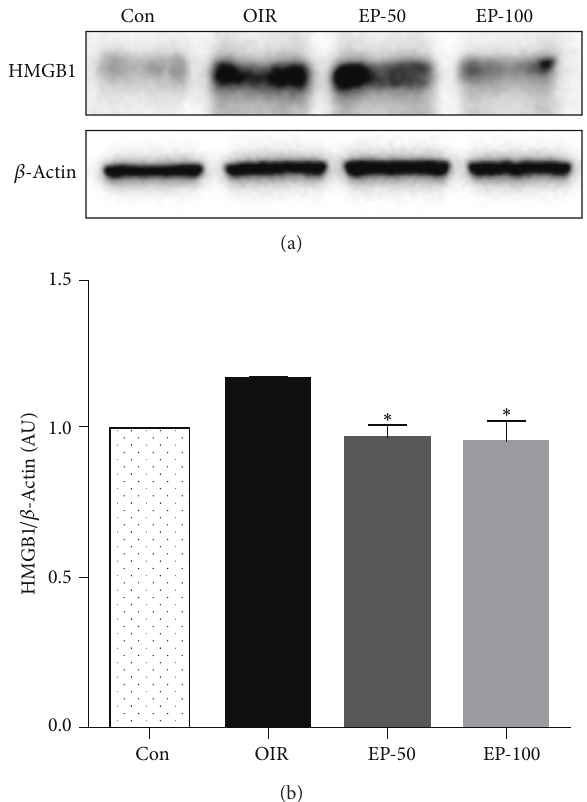
Figure 3: The effect of EP on retinal of HMGB1 expression in OIR mice. Western blot analysis in retina tissue from control (Con), OIR (OIR), 50mg/kg EP-treated (EP-50), and 100mg/kg EP-treated (EP-100) mice. The data are expressed as the mean ± SE (𝑛 = 6) . ∗ 𝑃 < 0.05 versus the OIR